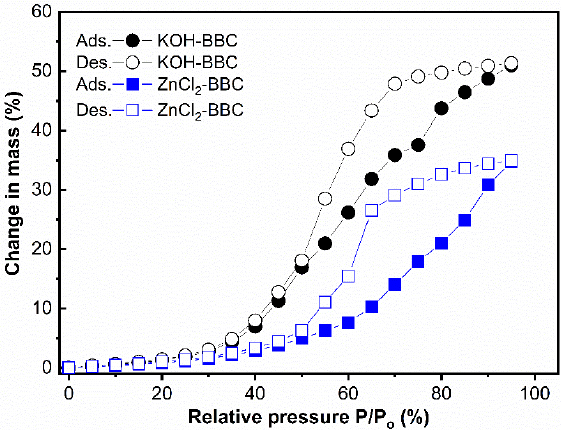
Figure 6. Water sorption isotherms for KOH-BBC and ZnCl 2 -BBC samples at 25 °C.